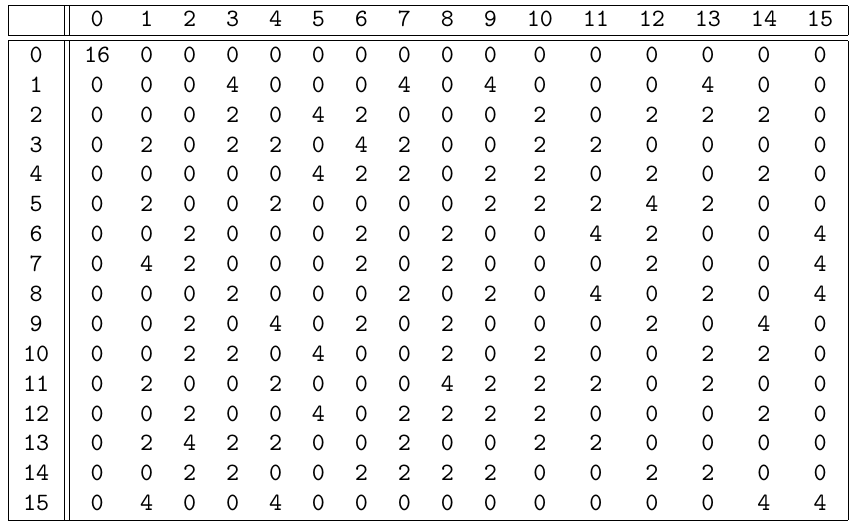
Table 10: DDT of the 4-bit Sbox used in